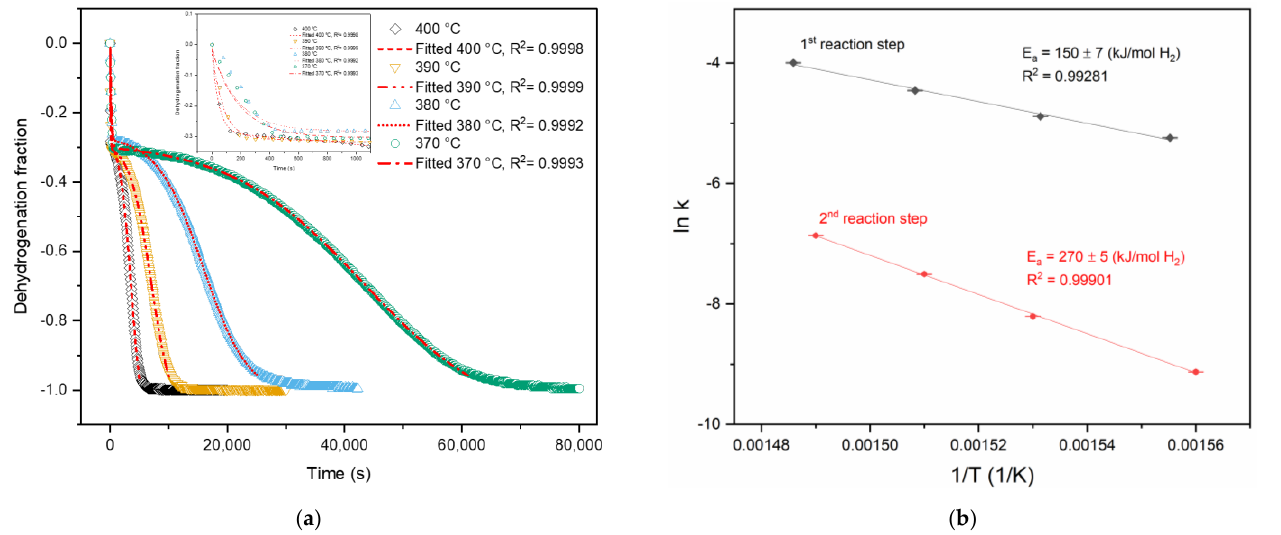
Figure 8. ( a ) The dehydrogenation kinetics and their fitted curves of Li-RHC + AlTi 3 sample at different temperatures; and ( b ) dehydrogenation activation energy of the Li-RHC + AlTi 3 sample.